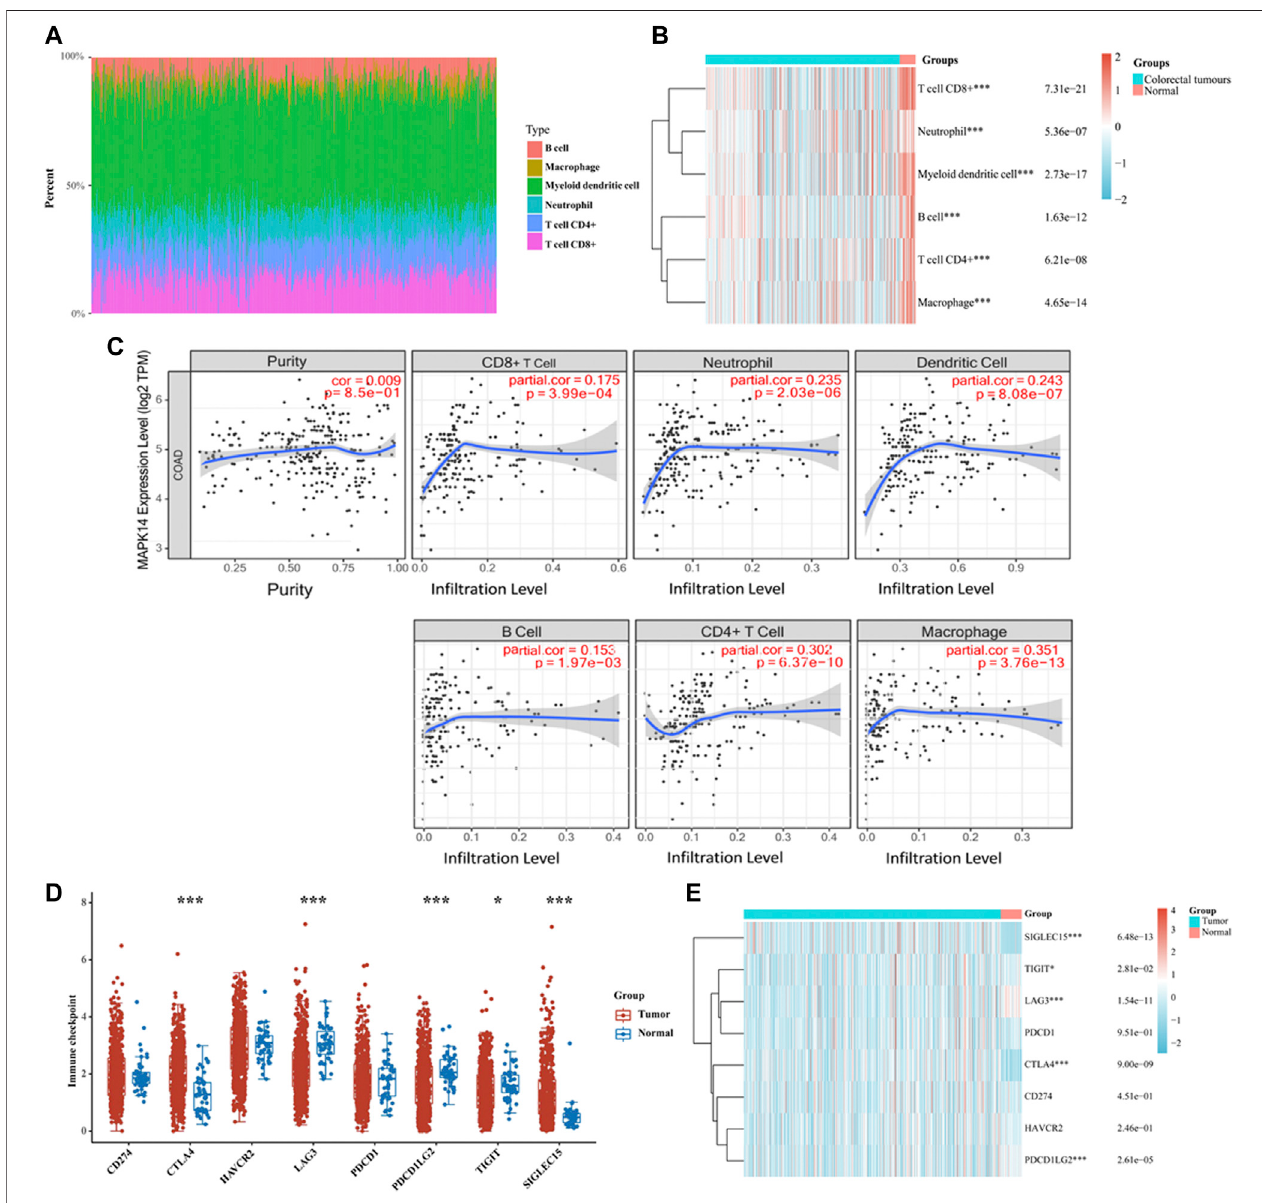
FIGURE 7 | Analysis of Mapk14 expression in CRC, including the immune score and immune checkpoint. (A) Percentage abundance of tumor-in fi ltrating immune cells in CRC samples. Different colors represent different immune cell types. Horizontal coordinates represent samples, and vertical coordinates represent the percentage of immune cell content in individual samples. (B) Heat map of immune cell scores. Different colors represent the expression trends in different samples. (C) Correlation analysis of Mapk14 expression in CRC with CD8 + T cells, neutrophils, dendritic cells, B cells, CD4 + T cells and macrophage immune cells. (D) Immune checkpoint expression distribution of the Mapk14 gene in CRC and normal tissues. (E) Heat map of immune checkpoint-associated gene expression. * p < 0.05, ** p < 0.01, *** p < 0.001.